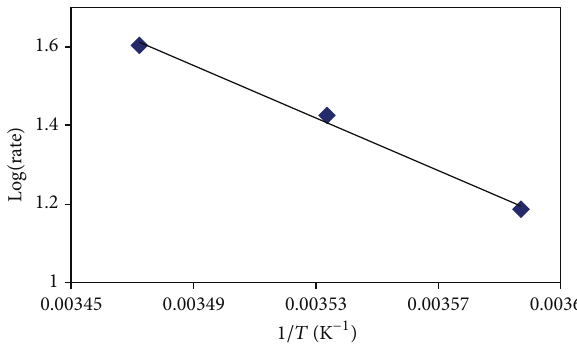
Figure8:Therelationbetweenthelogarithmofinitialrateand(1/ 𝑇 ) for aqueous oxidative polymerization of POPDA.